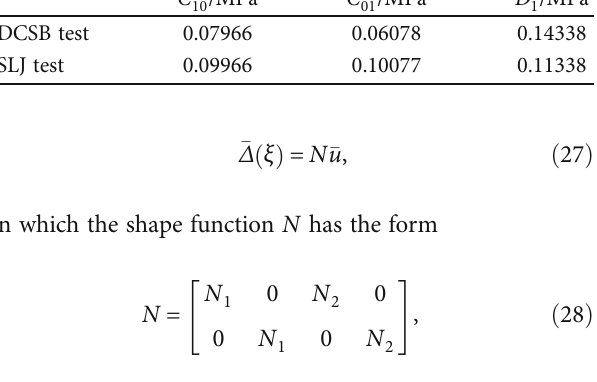
Table 2: The material coe ffi cients of the hyperelastic models of the insulation. C /MPa C 10 01